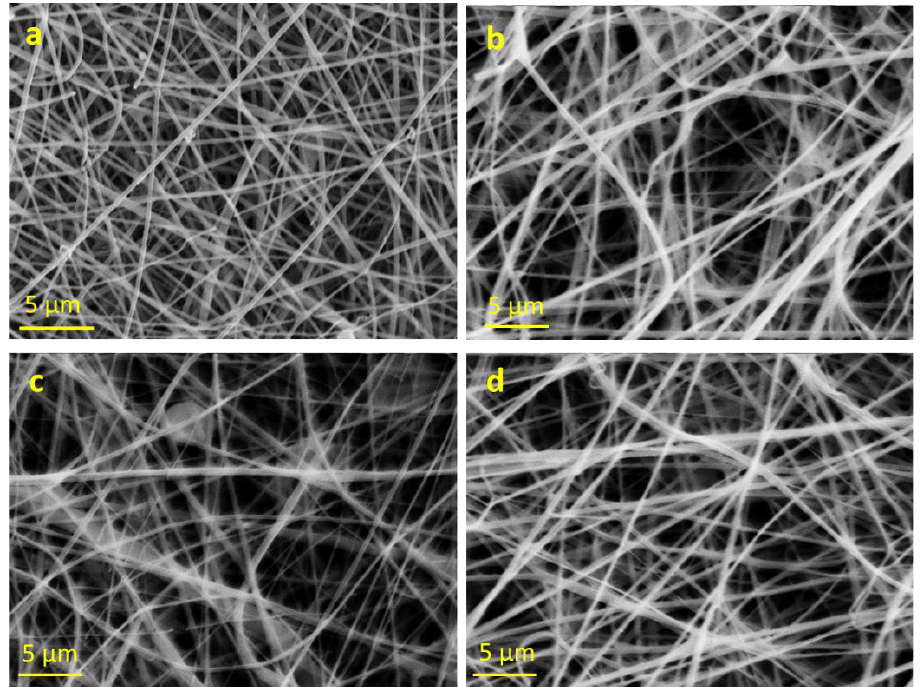
Figure 3. SEM images of PLA—AgNPs fibers, 7% ( w / w ) PLA in DCM/DMF: ( a ) Ag/PLA 4.7 wt.%;